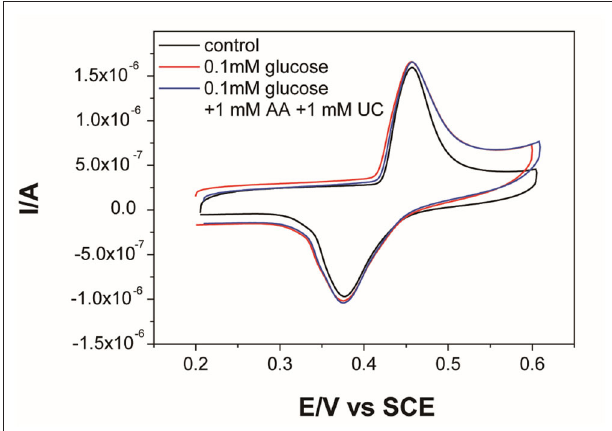
TABLE 1 | Comparative characteristics of the non-enzymatic MOFs based glucose sensors. Active materials Method Potential